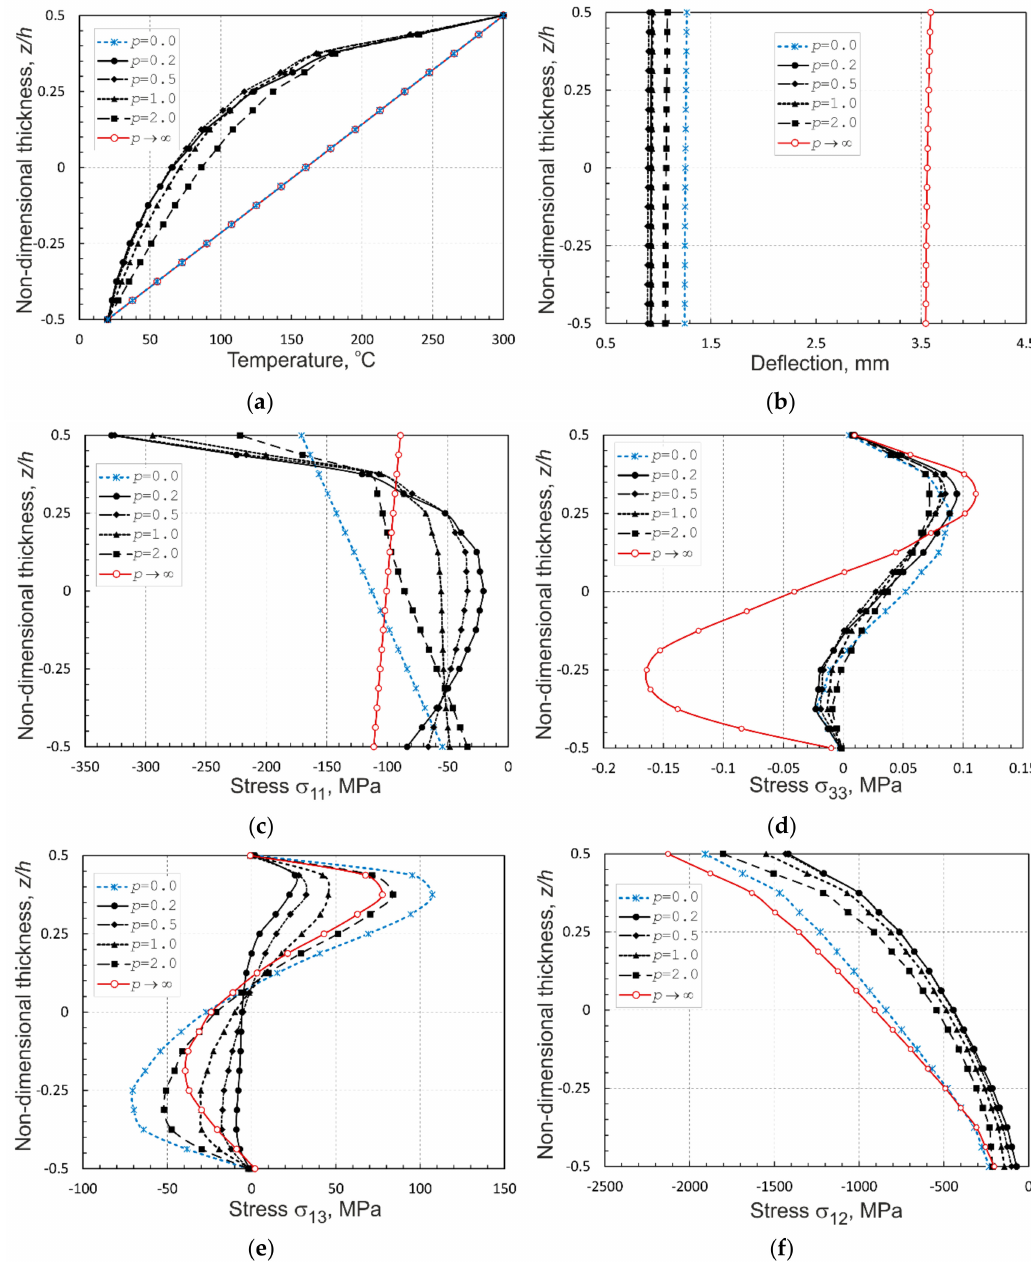
Figure 4. Through-the-thicknessprofilesof: ( a )temperatureat ( a /2, b /2, z ) ; ( b )deflectionat ( a /2, b /2, z ) ; ( c ) longitudinal normal stress σ 11 at ( a /2, b /2, z ) ; ( d ) transverse normal stress σ 33 at ( a /2, b /2, z ) ; ( e ) transverse shear stress σ 13 at ( 0, b /2, z ) ; and ( f ) in-plane shear stress σ 12 at ( 0, 0, z ) in the simply supported aluminum-zirconia FG square